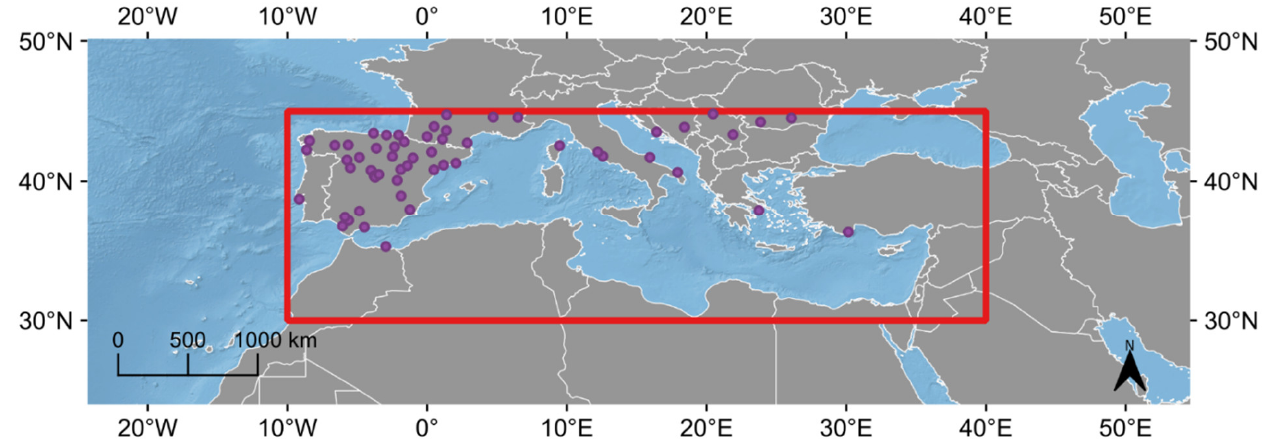
Figure 1. Locations of the 58 weather stations (in purple) from the GHCNd dataset were used in this study.